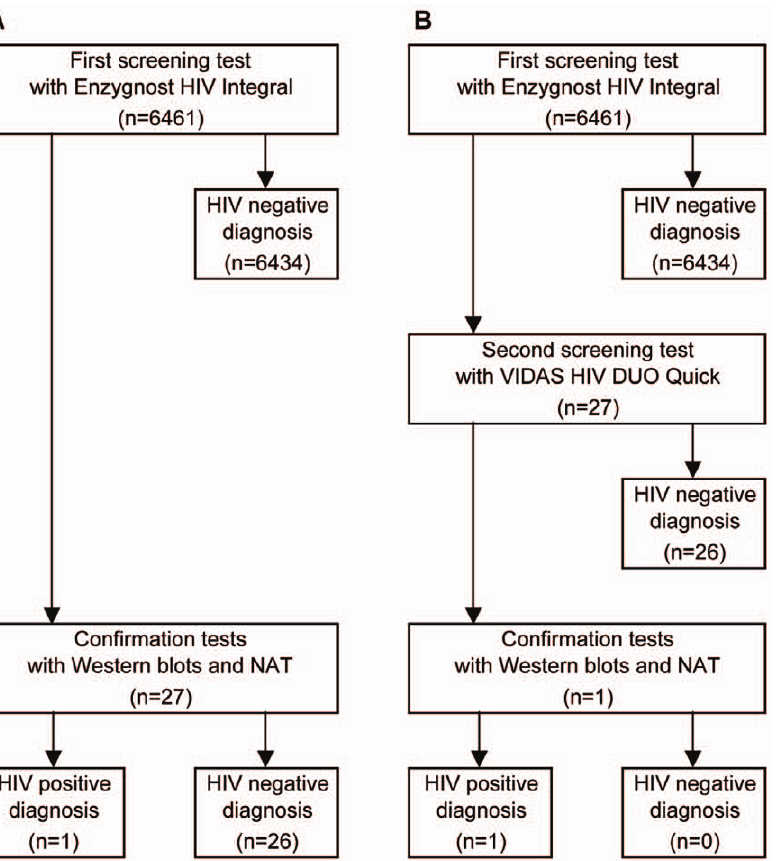
Figure 1. Comparison of the results obtained by two HIV testing algorithms. A , algorithm containing single test screening. B , algorithm containing serial two-test screening.